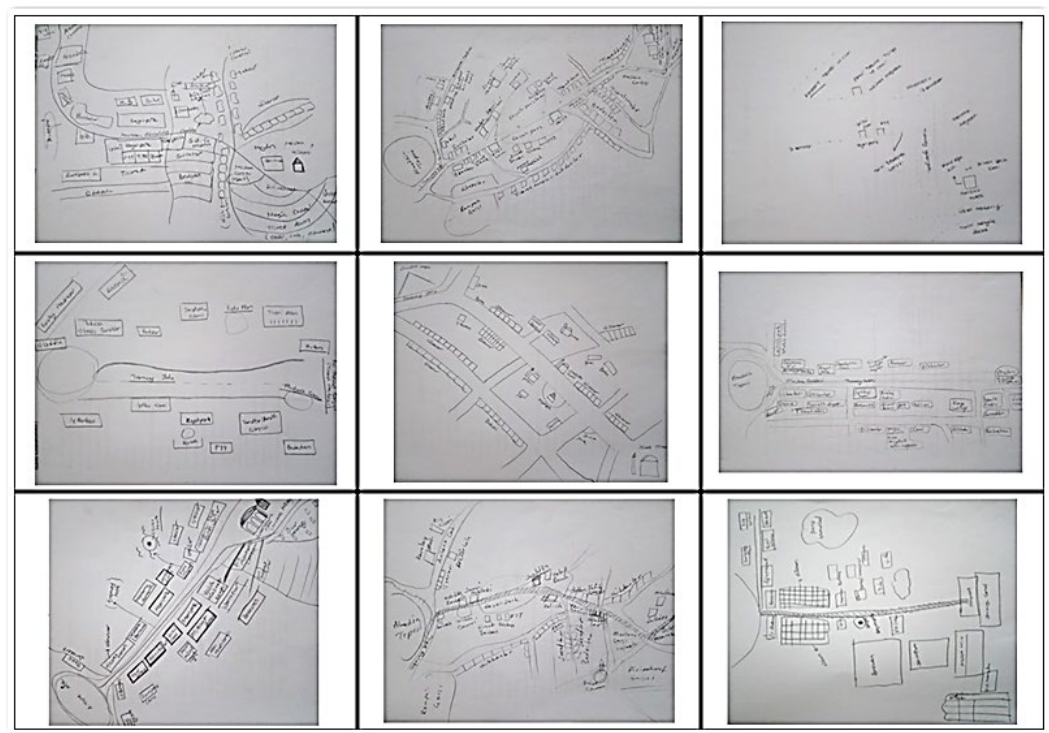
Figure 19 Cognitive map examples of the users (Ünal,